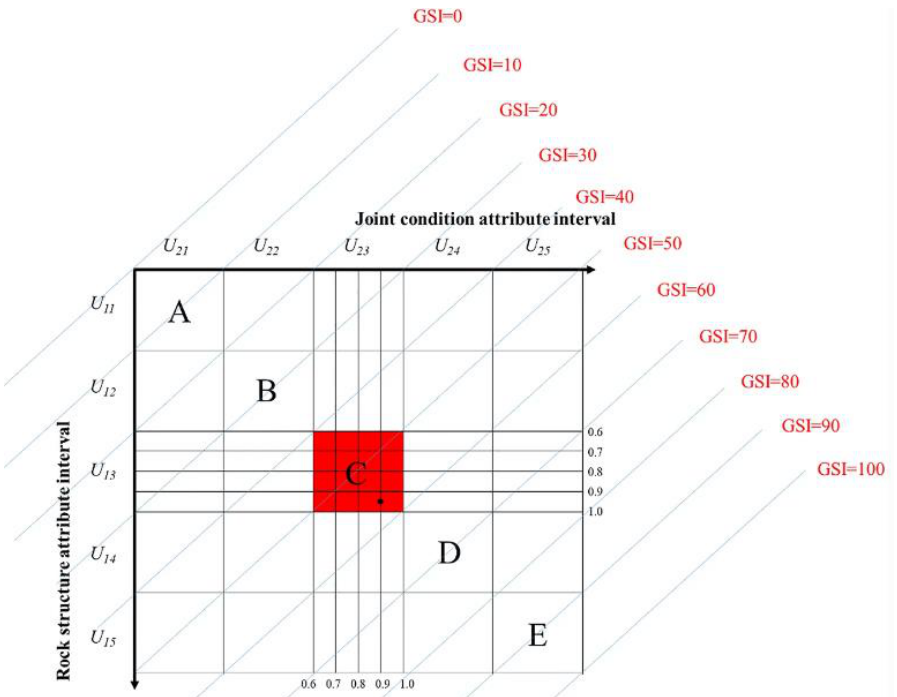
Figure A14. Quantified GSI chart [56].